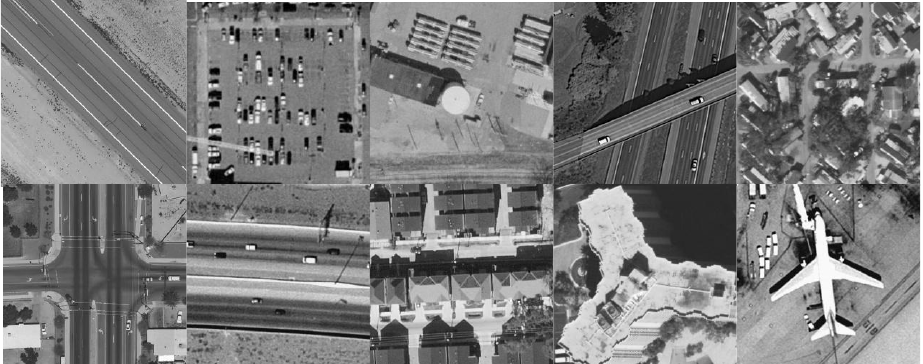
Figure 7. Part of the sample images used to train the